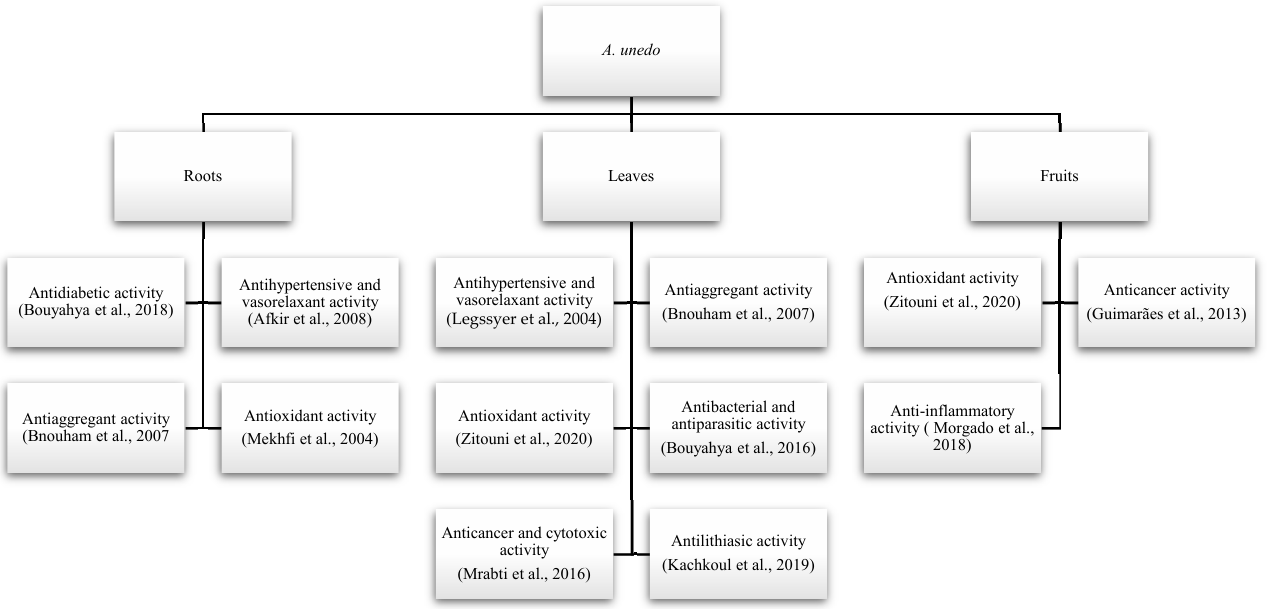
Figure 4. Biological and functional properties of Arbutus unedo L. plant.